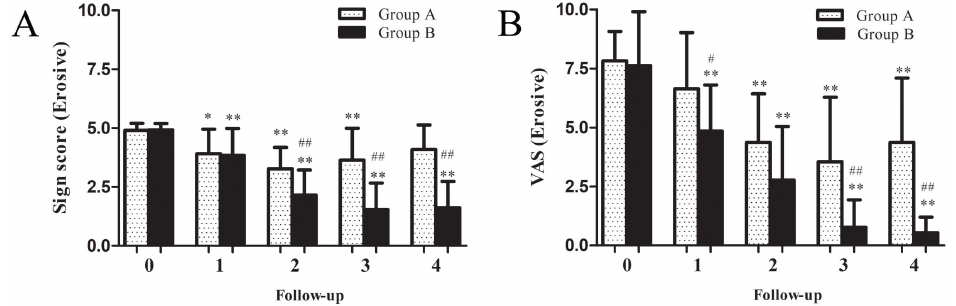
Figure 5. Sign score ( A ) and VAS ( B ) trends before and after treatment of patients with non-erosive OLP in Group A using dexamethasone plus gentamycin mouthwash and Group B by dexamethasone plus gentamycin mouthwash combined with TGP capsules. * Compared with initial visit of the same group, * p < 0.05, ** p < 0.01, # compared with group A at the same month, # p < 0.05, ## p < 0.01.